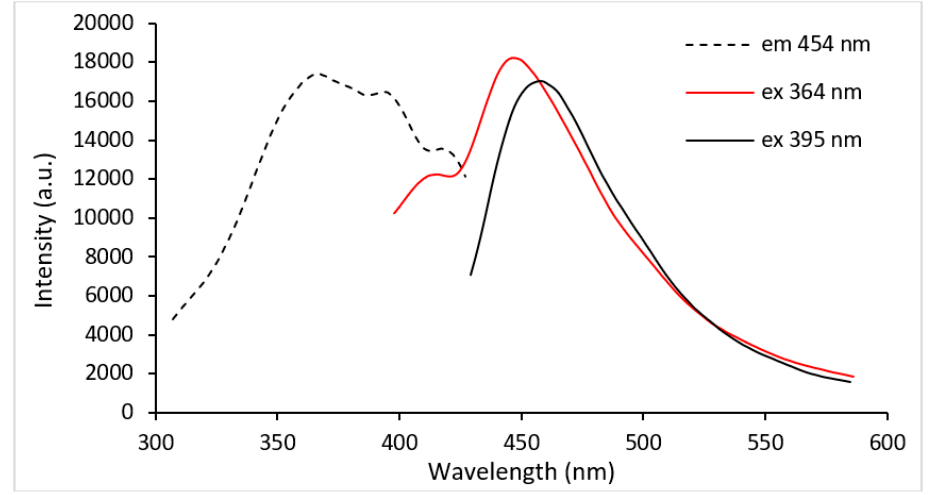
Figure 10. Fluorescence spectra of 3 wt% DMEA in silicone oil at room temperature in a 2 mm (op- tical path) flattened pyrex capillary. Emission wavelengths ( λ em = 454 nm; black, dotted line) and excitation wavelengths ( λ ex = 364 nm; red, solid line and 395 nm; black solid line). The capillary was placed at a 45° angle with respect to the incident beam and the detector direction (transmission).